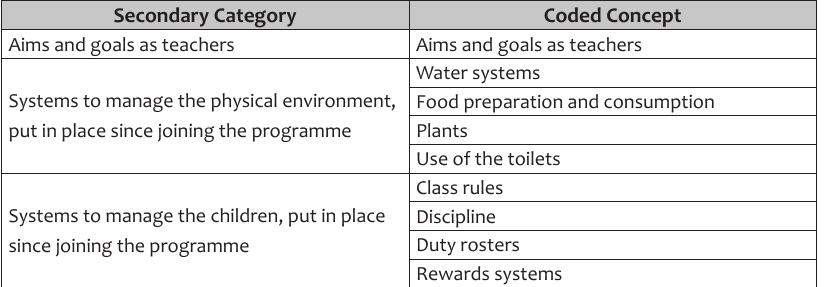
Table 2: Secondary categories and coded concepts for reported changes in